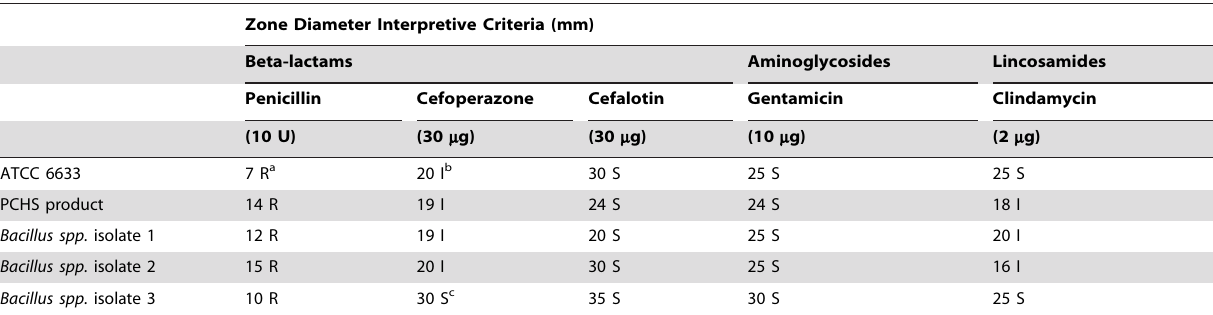
Table 1. Antibiograms on Bacillus spp. from the cleaning products and